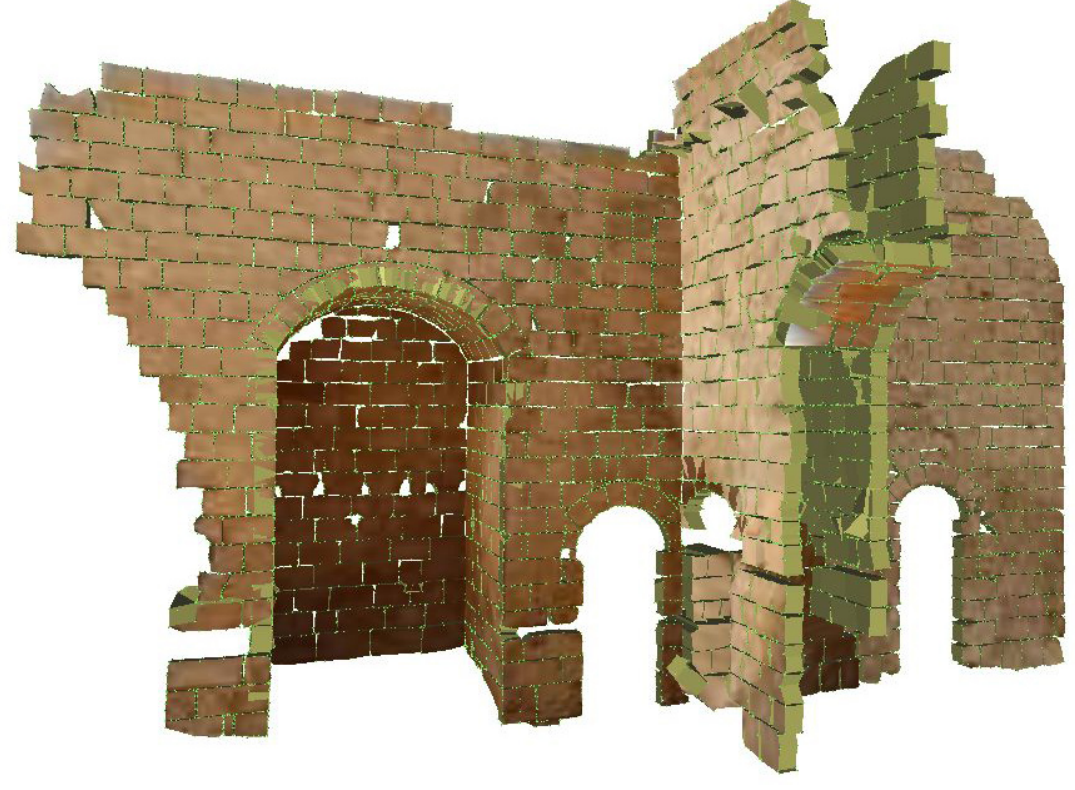
Figure 8. An example of the stone-by-stone survey using an extrusion vector from CF34 (the Ayyubid Palace in